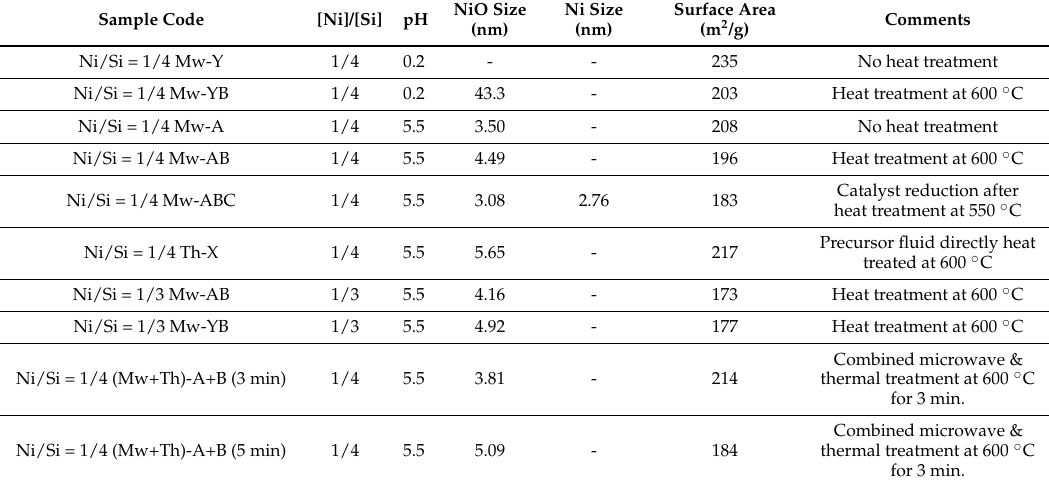
Table 1. The effect of pH and processing conditions at various stages on the surface area and catalyst crystallite size based on the dominant XRD